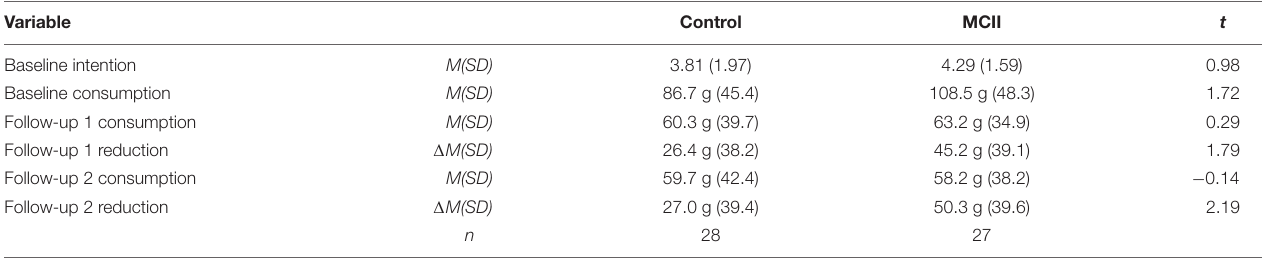
TABLE 1 | Means and standard deviations for the intention to reduce meat consumption, meat consumption levels, and meat reduction in g/day.